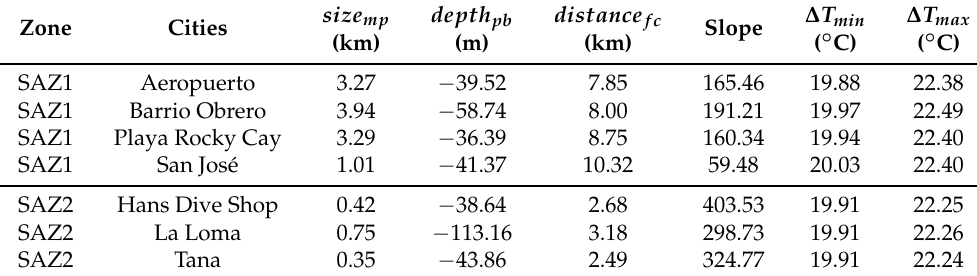
size mp depth pb distance fc